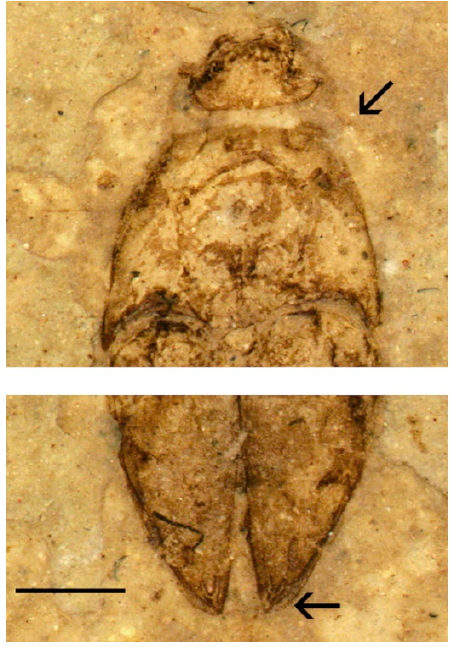
Figure 5. Apoclion dolini Chang, Kirejtshuk & Ren, holotype. Head and part of prothorax, antenna with subapically attached antennomere 2, and three enlarged apical antennomeres (upper arrow); apex of elytra with excretory punctures (lower arrow). Scale 1 mm.